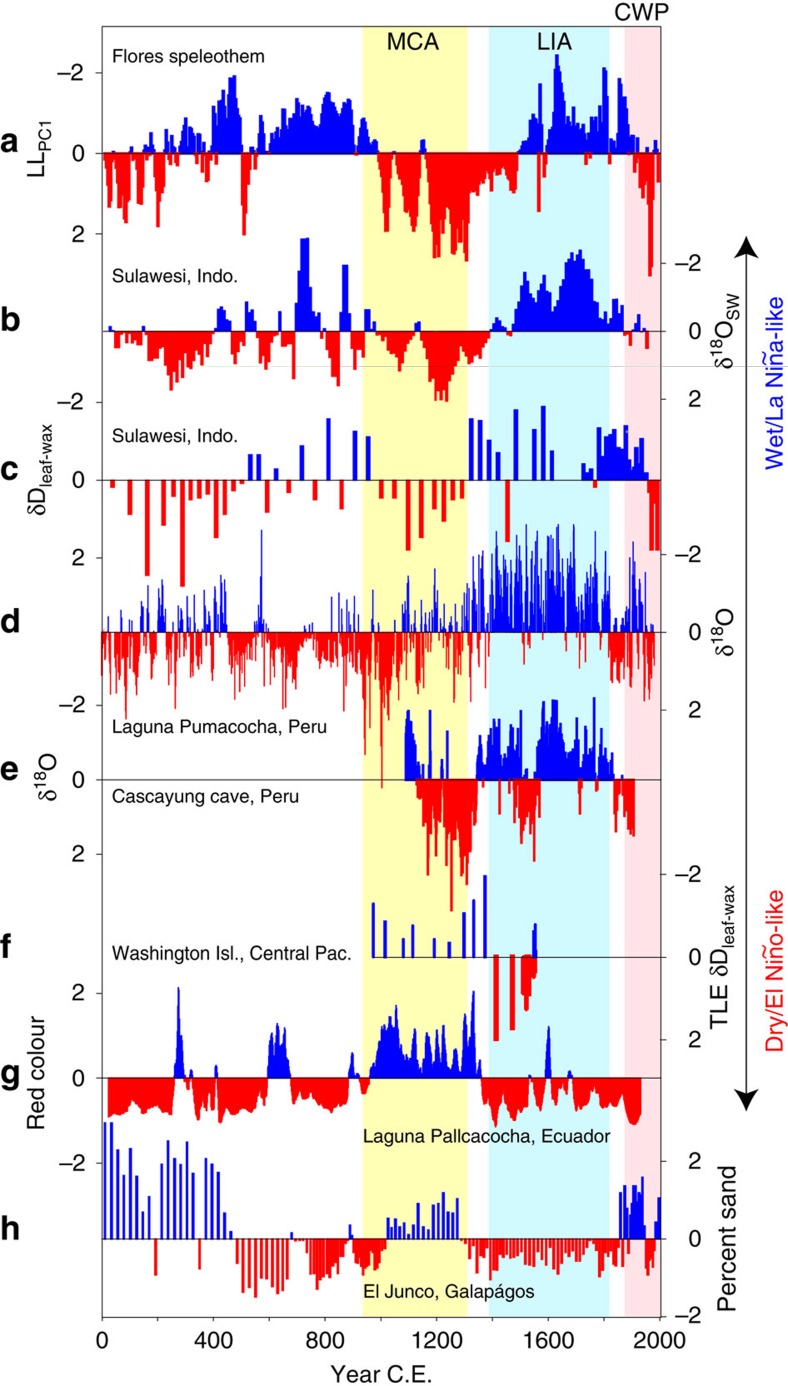
Hydroclimate records for the tropical western and eastern Pacific.(a) Flores LLPC1 record. (b) Marine foraminifera δ18Osw (ref. 5) and (c) terrestrial δDleaf-wax (ref. 6) records recovered from marine sediment cores located in the Makassar Strait on the Sulawesi margin. (d) δ18O of lake sediment calcite in Laguna Pumacocha in the central Peruvian Andes (proxy for the strength of the South American summer monsoon)44. (e) Speleothem δ18O record from Cascayunga cave in northeast Peru46. (f) δDleaf-wax record from Washington Island in the central equatorial Pacific8. (g) Red-colour intensity from Laguna Pallcacocha, southern Ecuador47. (h) Percent sand in El Junco lake, Galápagos Islands10. For clarity, all records have been converted to standard (z) scores with blue indicating wetter conditions (a–f) or heavier precipitation events (g–h) and vice versa for red. Vertical bars indicate the approximate timing of the MCA (yellow), LIA (blue) and CWP (pink) in Flores.